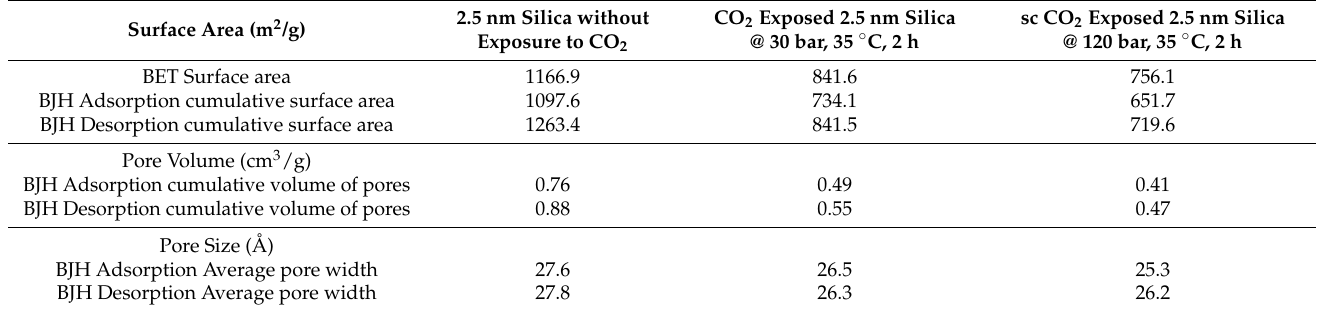
Table 5. The surface area of 2.5 nm silica before and after exposure to CO 2 or supercritical (sc) CO 2